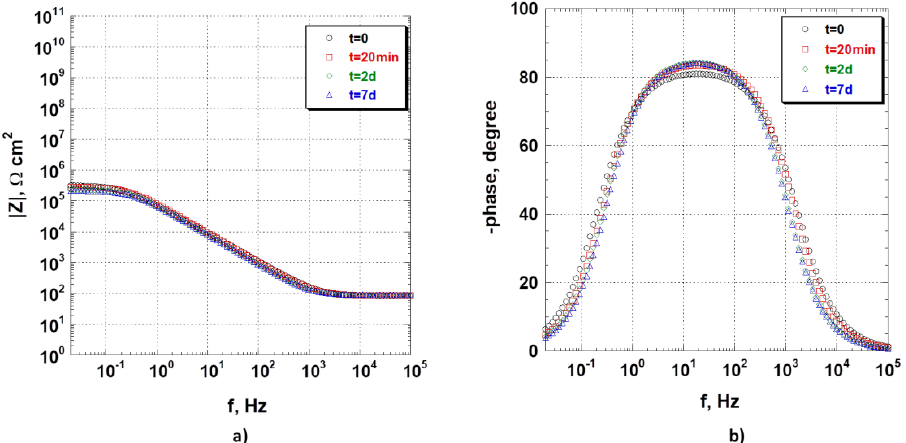
Figure 6. ( a ) Impedance modulus |Z|; ( b ) phase angle plots of bare sample immersed in an aer- ated 3.5 wt.% NaCl solution for 7 days.